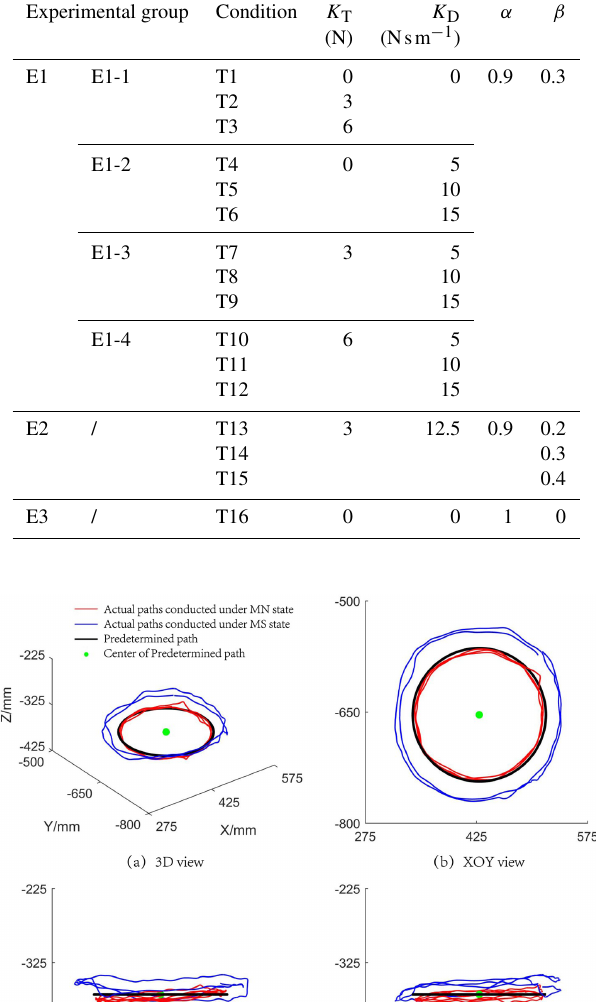
Table 2. Experimental arrangement.